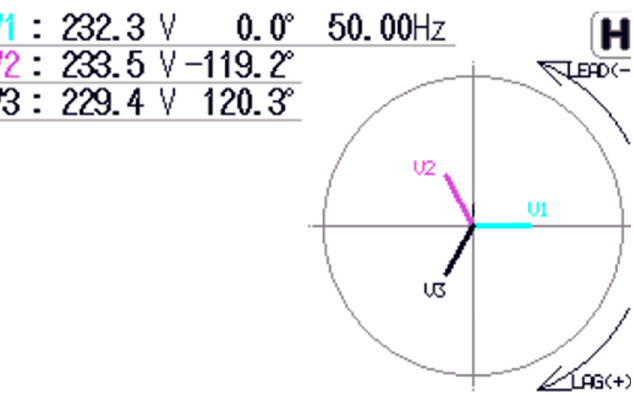
Figure 1. The angular asymmetry between voltage vectors: reference grid measurement.